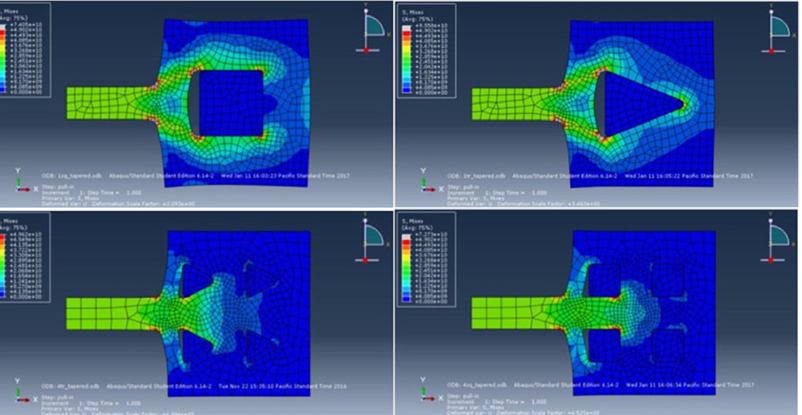
Figure 7. Four gNEMS nail design splits, including one square nail, one triangular nail, four smaller square nails, and four smaller triangular nails, for a comparison study of fracture stress in graphene ribbons in gNEMS devices.